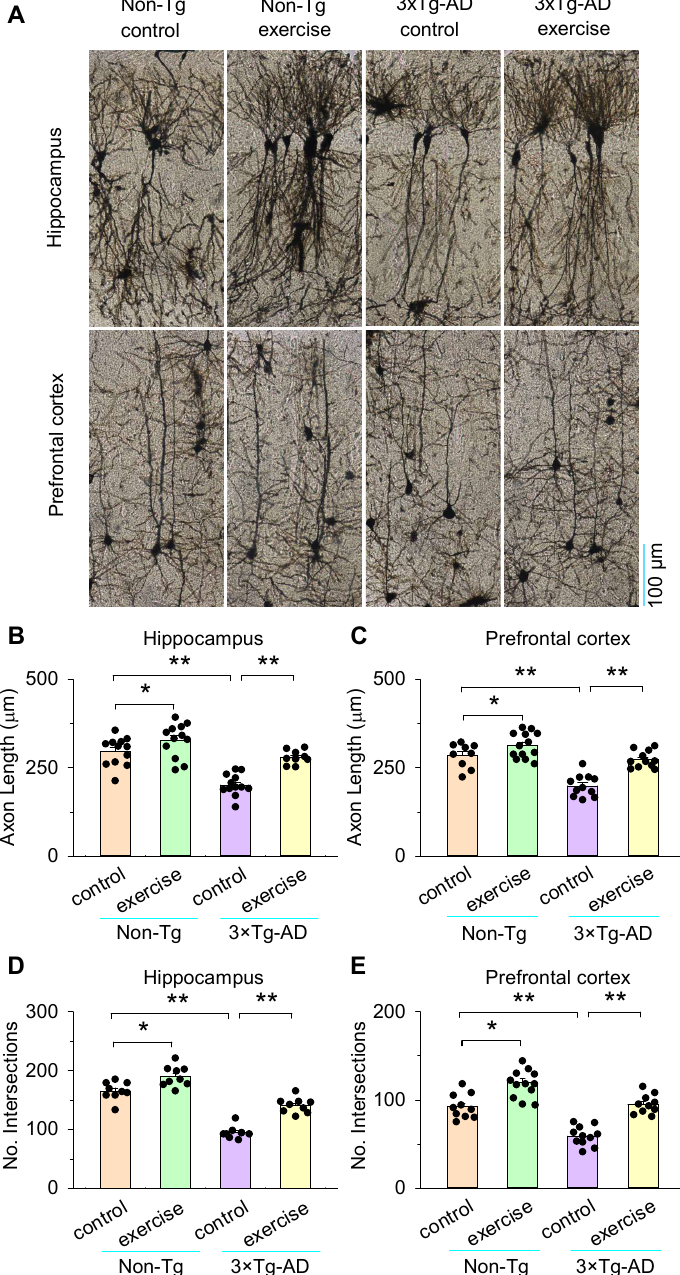
Figure 5. Treadmill exercise enhance the axon length and dendritic complexity of the